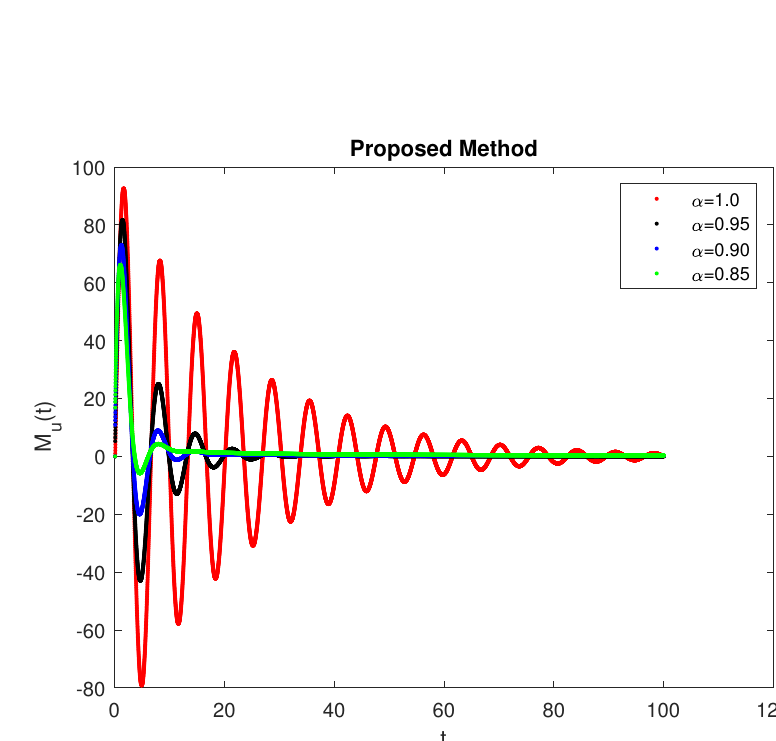
Figure 4: Numerical simulations for τ = 0.98 for ABC